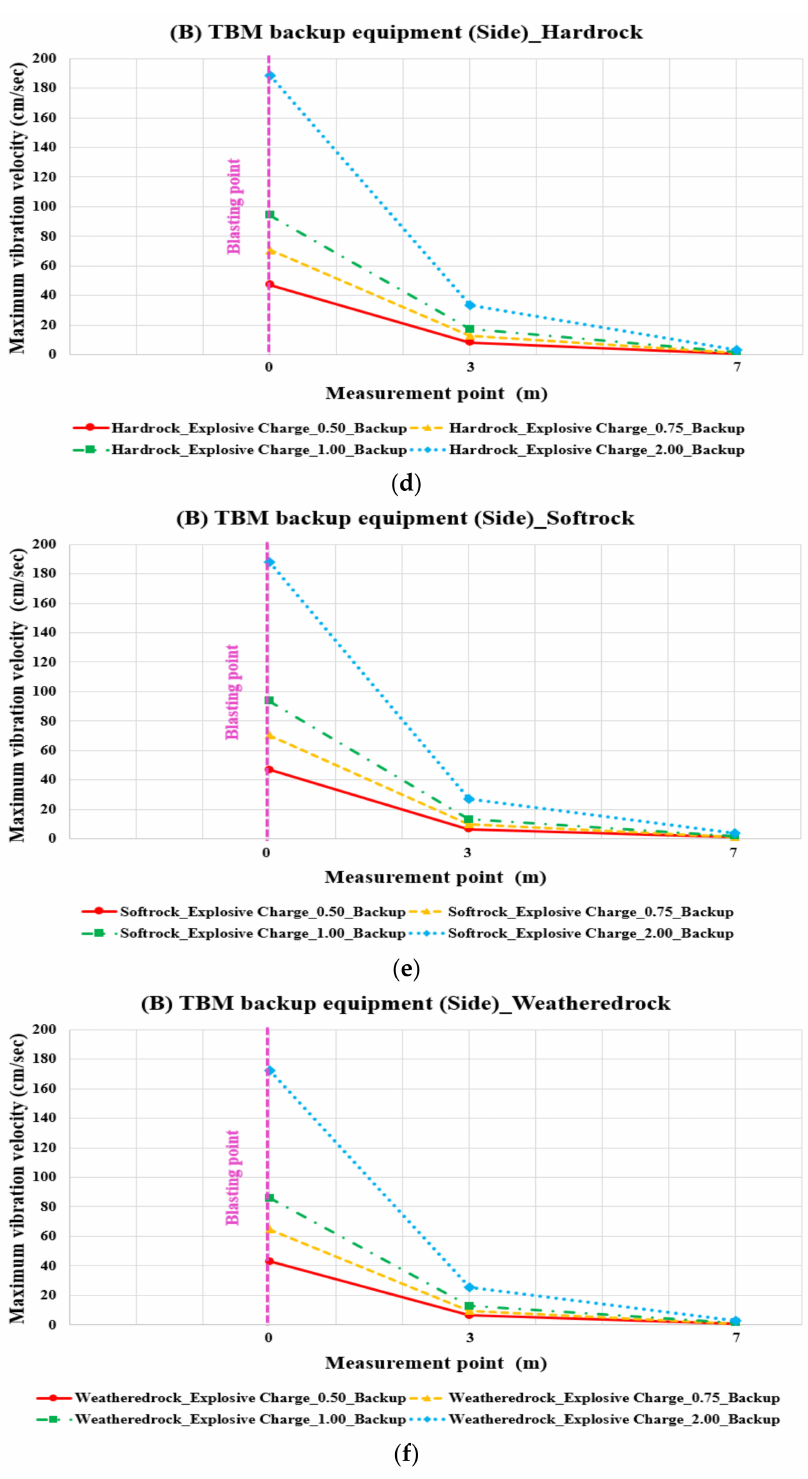
Figure 5. Analysis results for vibration velocity according to rock type and powder factor (measure- ment points A and B): ( a ) bottom of the TBM backup (hard rock), ( b ) bottom of the TBM backup (soft rock), ( c ) bottom of the TBM backup (weathered rock), ( d ) side of the TBM backup (hard rock), ( e ) side of the TBM backup (soft rock), and ( f ) side of the TBM backup (weathered